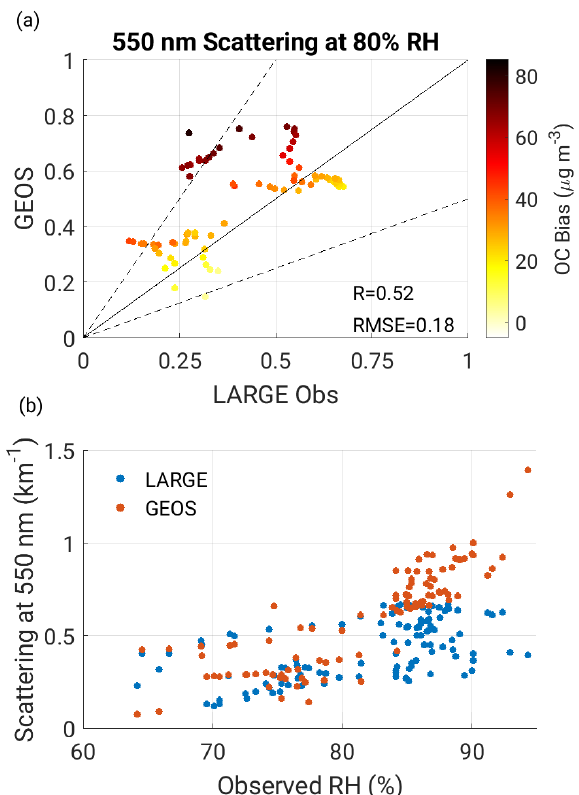
Figure 10. (a) Scatter plot of observations from LARGE versus GEOS GOCART2G for scattering at 550nm at a relative humidity of 80% colored based on the bias in organic carbon mass concen- tration. The solid black line represents the one-to-one line, while dashed black lines are the two-to-one lines. (b) Scatter plot of observed relative humidity versus scattering at 550nm from the LARGE observations and GOCART2G that has been bias-corrected for relative humidity.